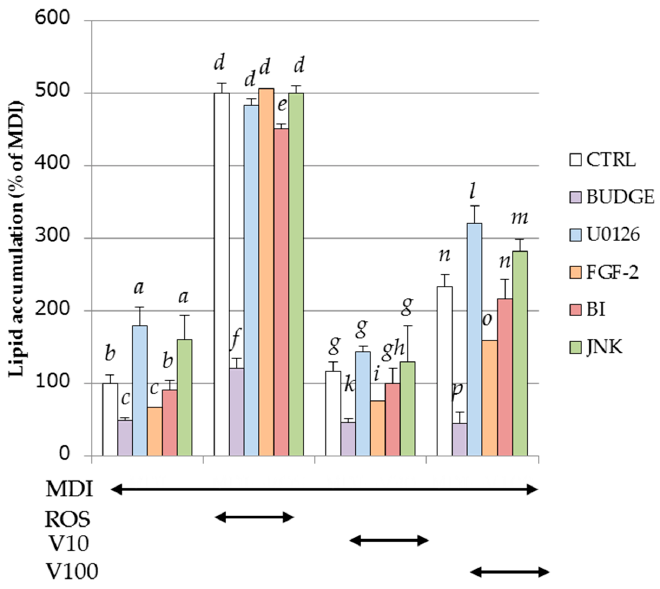
Figure 8. The effects of each inhibitor on triglycerol levels in 3T3-L1 cells during adipogenesis.